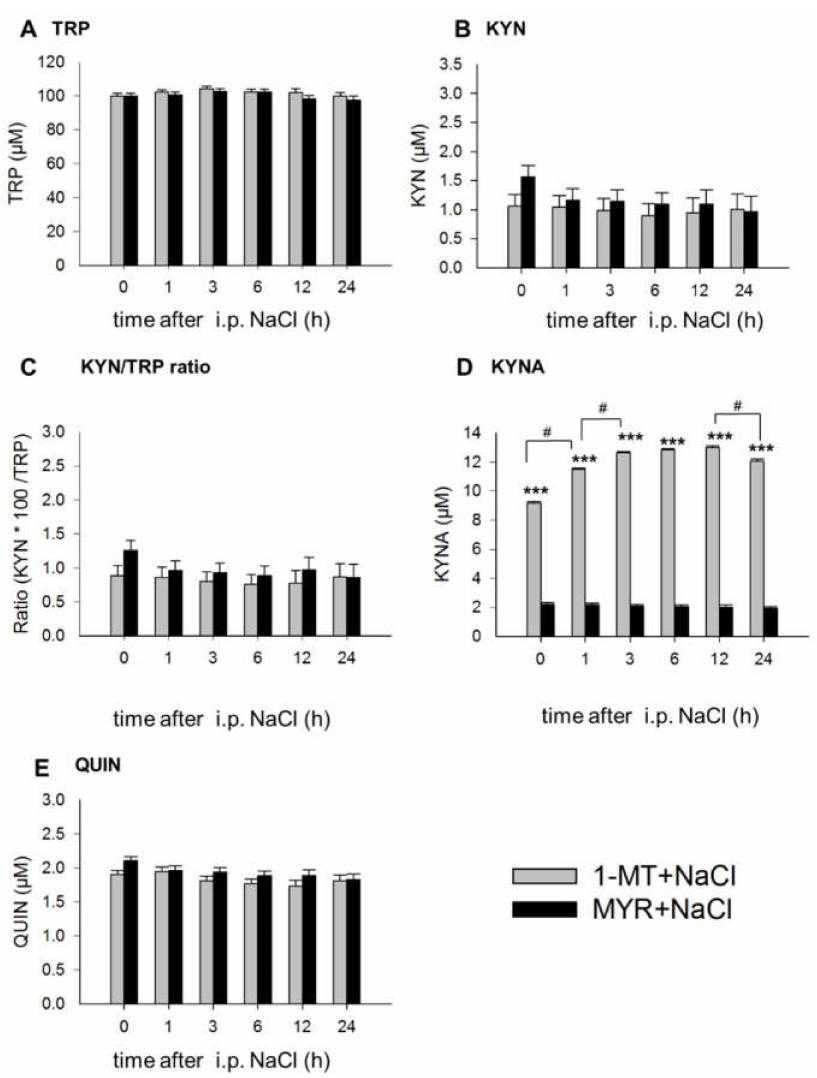
Figure A2. Effect of 1-MT on TRP ( A ), KYN ( B ), KYN/TRP ratio ( C ), KYNA ( D ) and QUIN ( E ) in plasma after i.p. NaCl administration. As a control for 1-MT-induced effects the excipient MYR was used. TRP and its metabolites were measured using MS/MS and the KYN/TRP ratio was used as a marker for IDO1 activity. NaCl was injected i.p. directly after blood sampling at 0 h. The animals received the fifth s.c. 1-MT or MYR injection at 12 h after NaCl. The results are presented as LS-means ± SE. Tukey–Kramer procedure was used for all pairwise comparisons. Significant differences are indicated between 1-MT and MYR groups for each time point by asterisks, and between the sampling times by hashes. For the sampling times 0, 1, 3, 6 h: n = 11-12/group (total n = 47); for time point 24 h: n = 5-6/group (total n = 23); *** p < 0.001, # p <